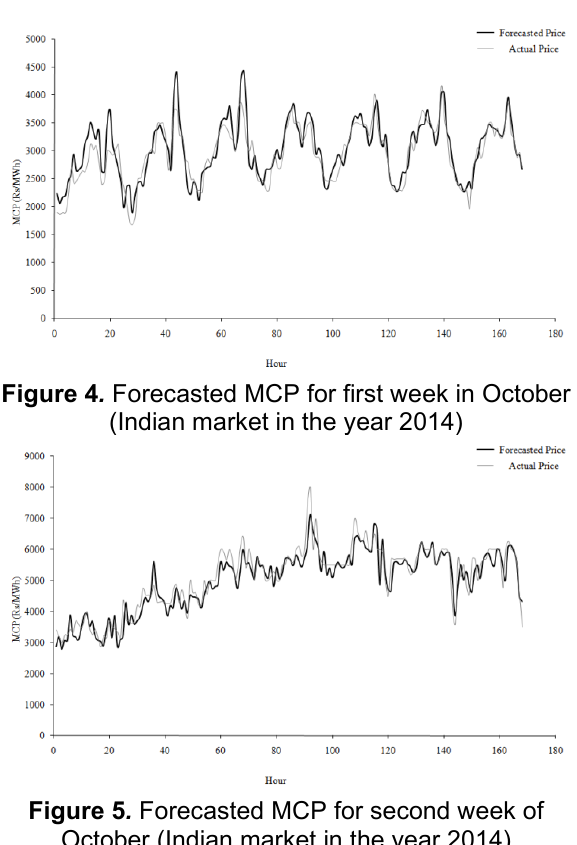
Figure 5 . Forecasted MCP for second week of